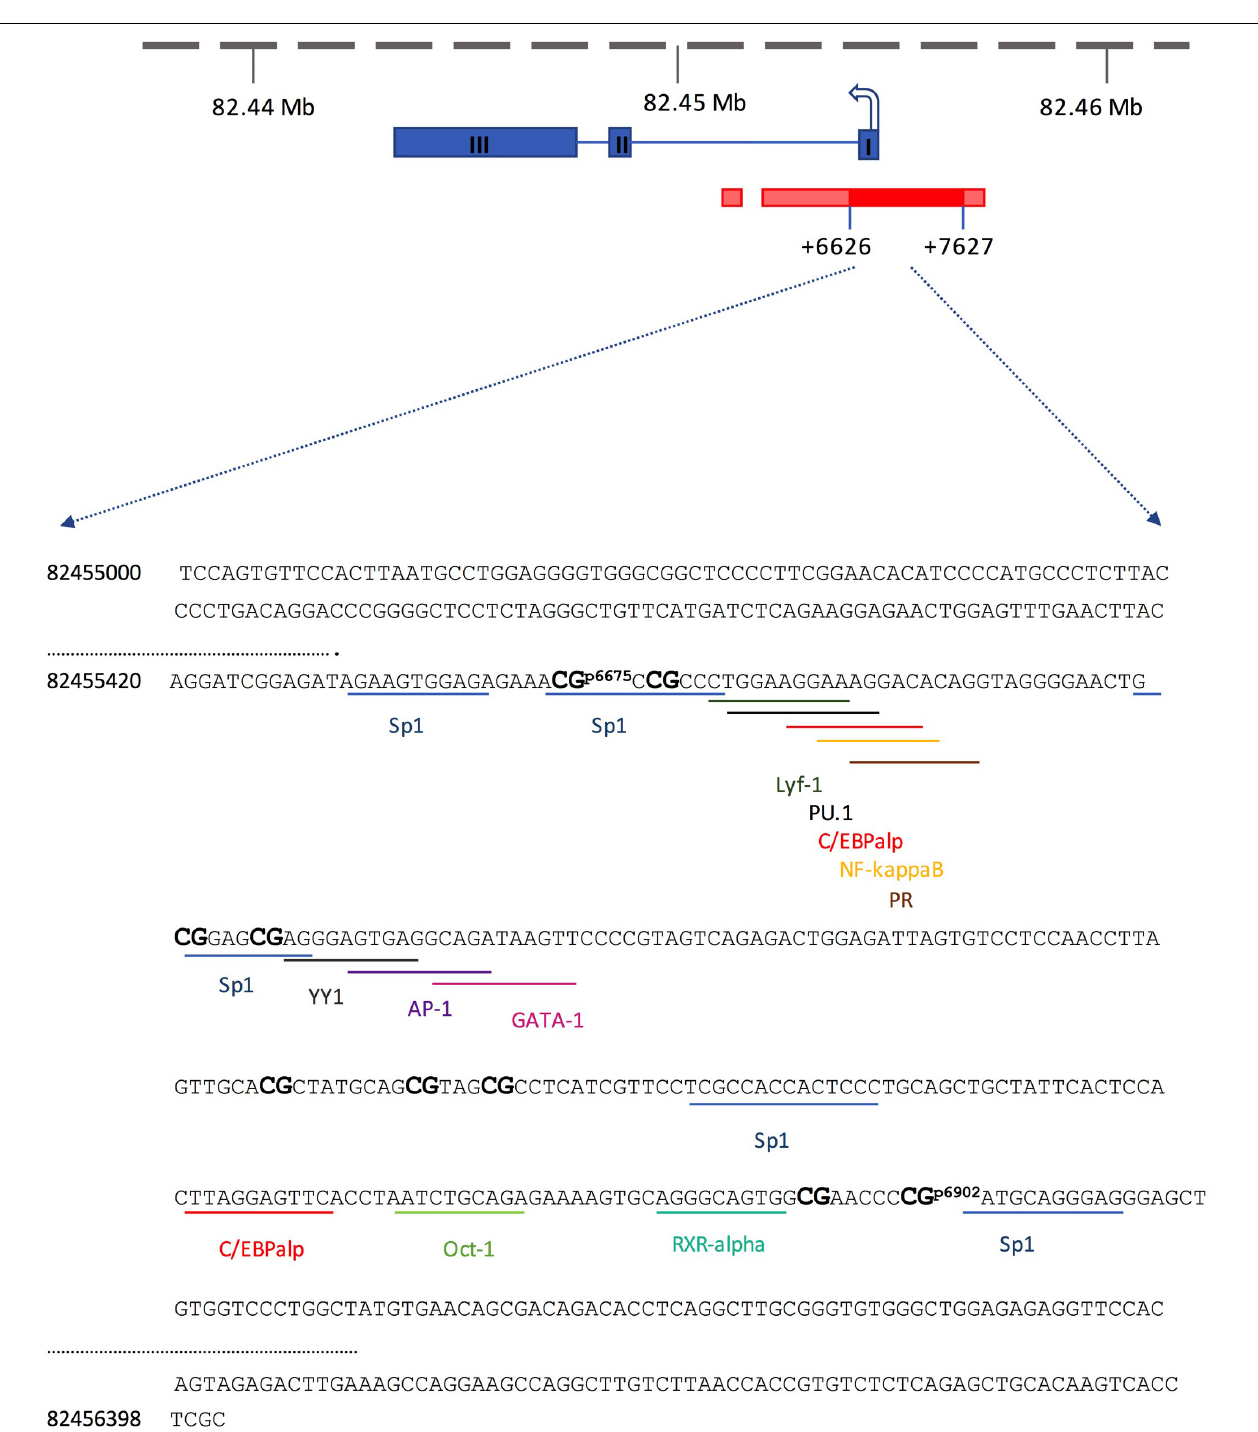
FIGURE 2 | Schematic depiction of the mouse Y2 receptor gene, including the positions of the 9 analyzed CpG sites and the transcription factor binding sites (blue: exon; dark red: core promoter; red: promoter bounds and flanking region). The sequences of the promoter region are shown as a forward strand (NCBI, Gene ID: